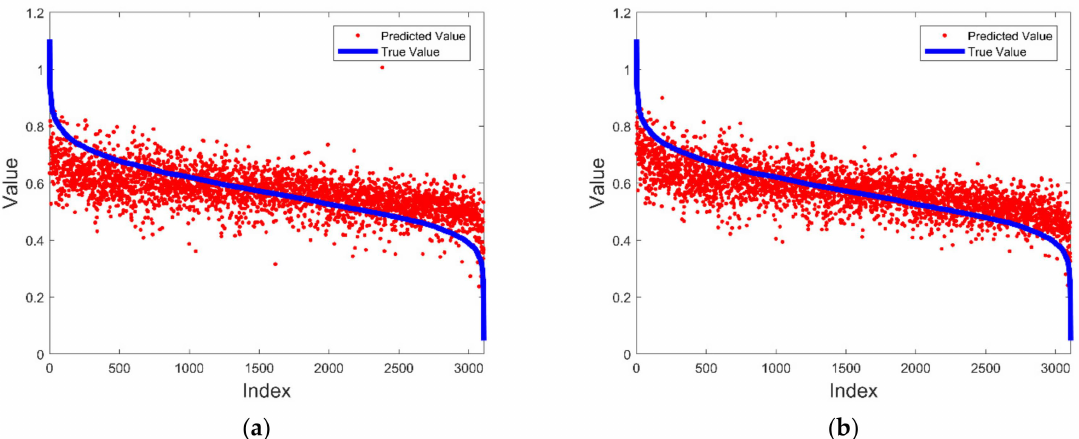
Figure 8. Election dataset prediction results obtained with the models fused with the 0–1 type spatial weight matrix: ( a ) conventional LS-SVR model; ( b ) Geo LS-SVR